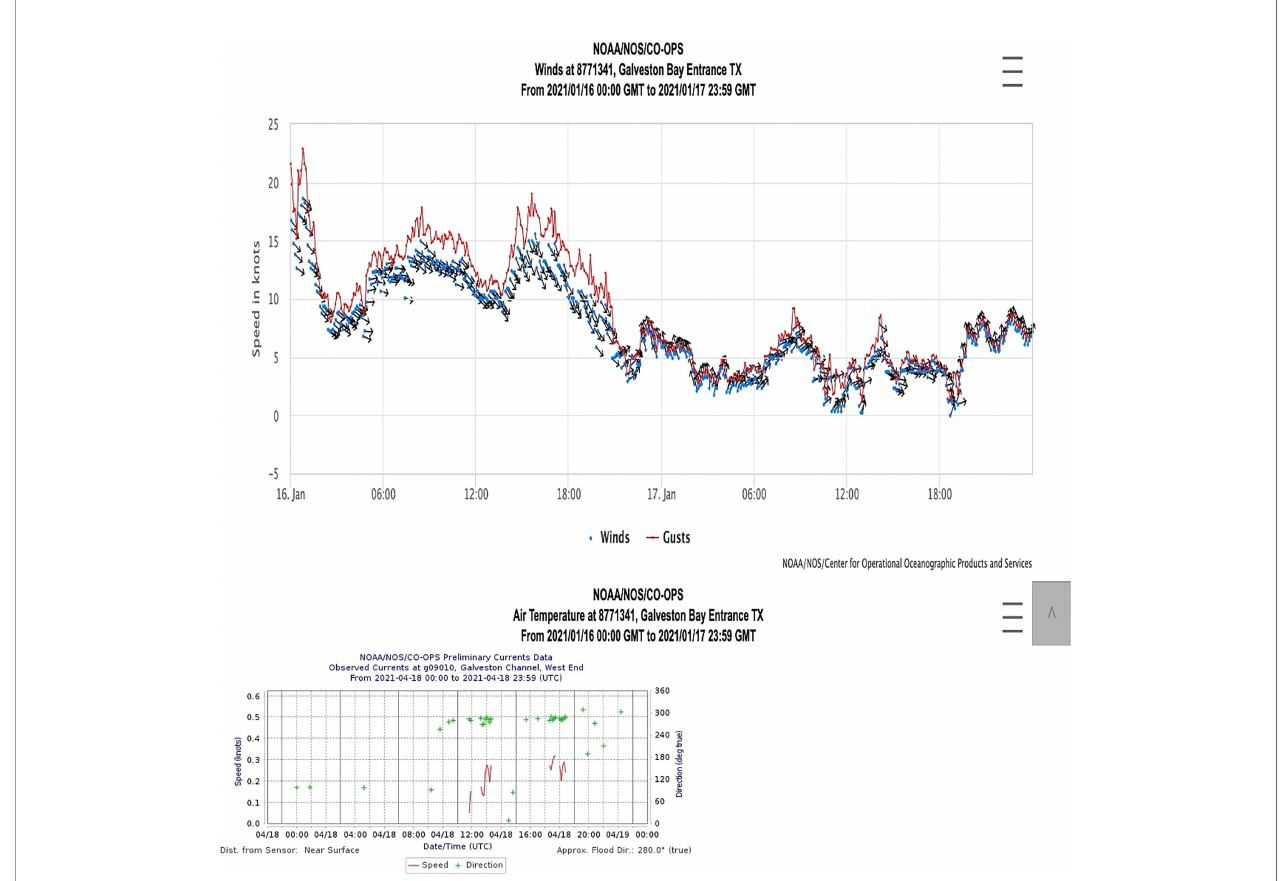
FIGURE 10 | Validation of the nearby meteorological and oceanography